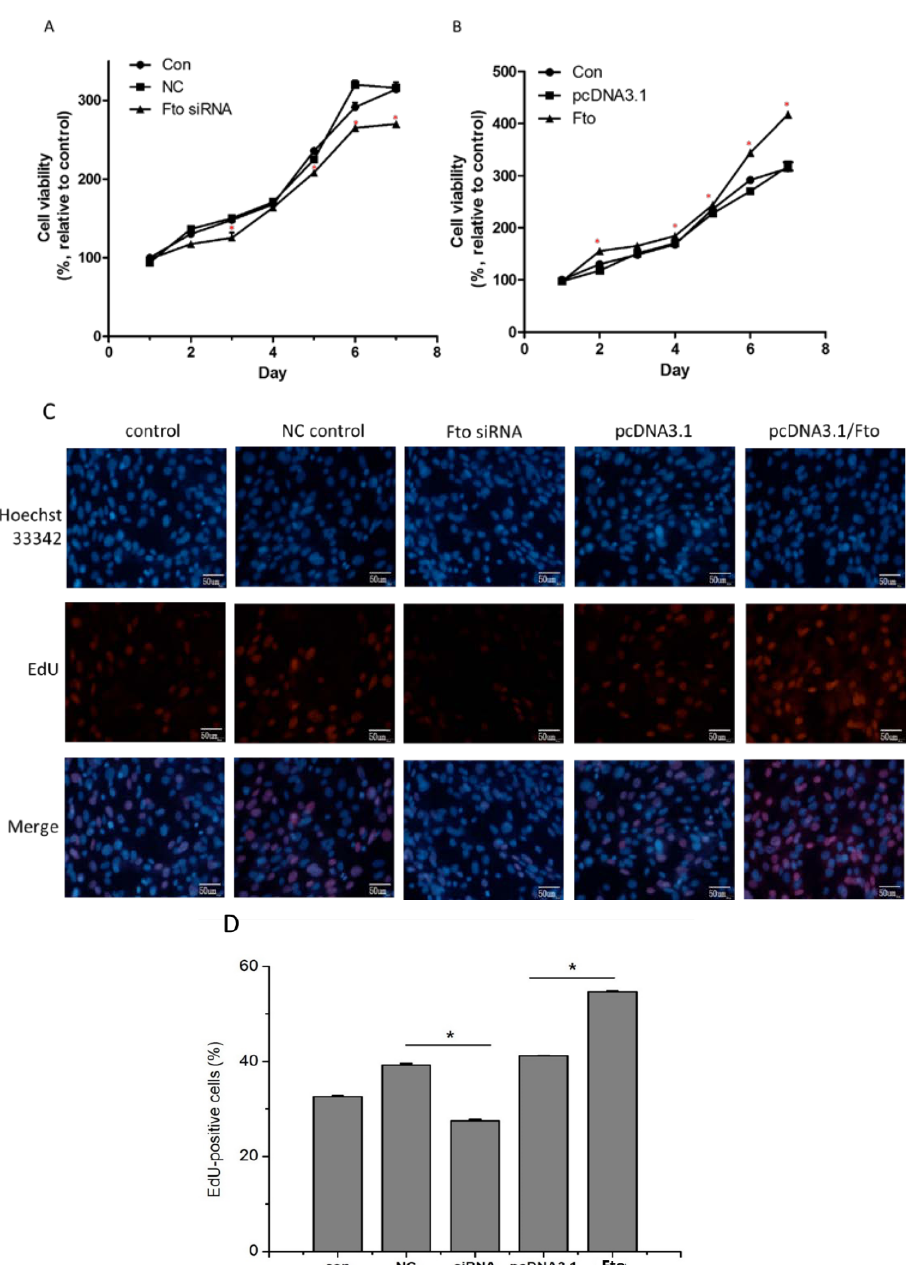
Figure 2. Fto affected 3T3-L1 cell proliferation. 3T3-L1 cells were transfected with Fto siRNA and NC siRNA ( A ), or transfected with Fto expression plasmid and vacant plasmid pcDNA3.1 ( B ) for 24 h. Cells were seeded in 24-well plates and were counted at Day 1 to Day 7, respectively. Cell viability was expressed as the percentage of viable cells relative to cell viability detected in the mock transfected control cells. All samples were detected in triplicate. * p < 0.05, versus control. ( C ) 3T3-L1 cells were transfected with siRNA and plasmid for 24 h, and after adipogenic induction for another 24 h, then the cell proliferation was analyzed via EdU incorporation. The representative images were shown as above; EdU (Red), Hoechest 33342 (blue); scale bar, 50 μM. ( D ) Quantification analysis of EdU positive cells.